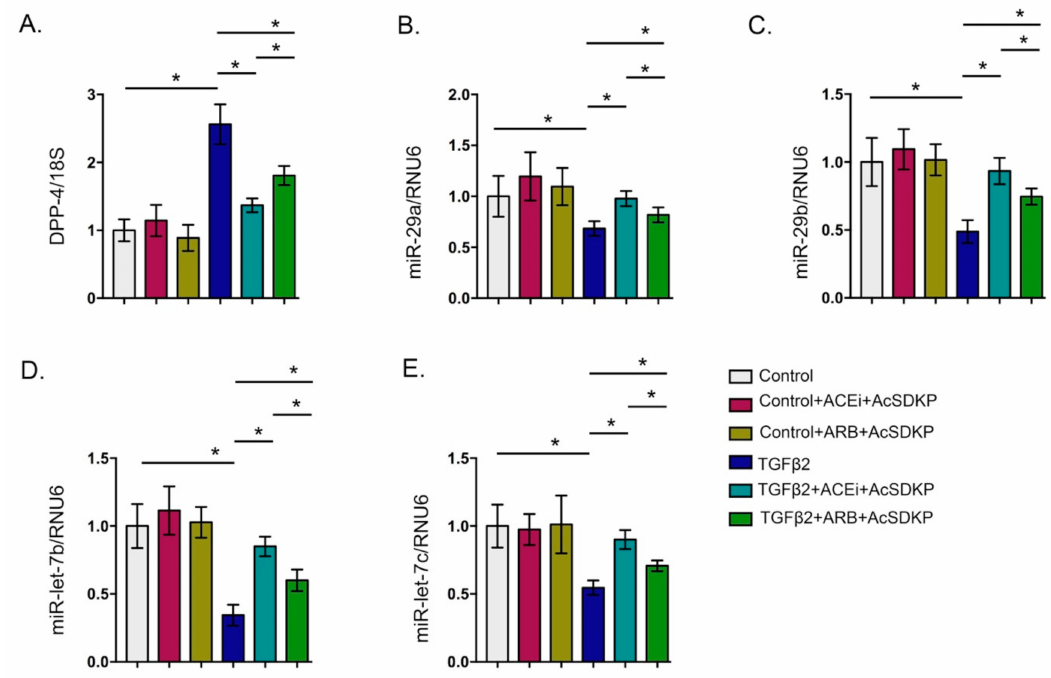
Figure 5. Gene expression analysis of DPP-4 and antifibrotic microRNAs in the combination treatments (ACEi + AcSDKP and ARB + AcSDKP). ( A ) Gene expression analysis of DPP-4 mRNA. ( B – C ) Gene expression analysis of miR-29 family members and miR-let-7 family member in the TGF β 2-stimulated HMVECs. N = 5 were analyzed in each group Data in the graph are presented as mean ± SEM. One-way Anova Tukey test was performed for calculation of statistical